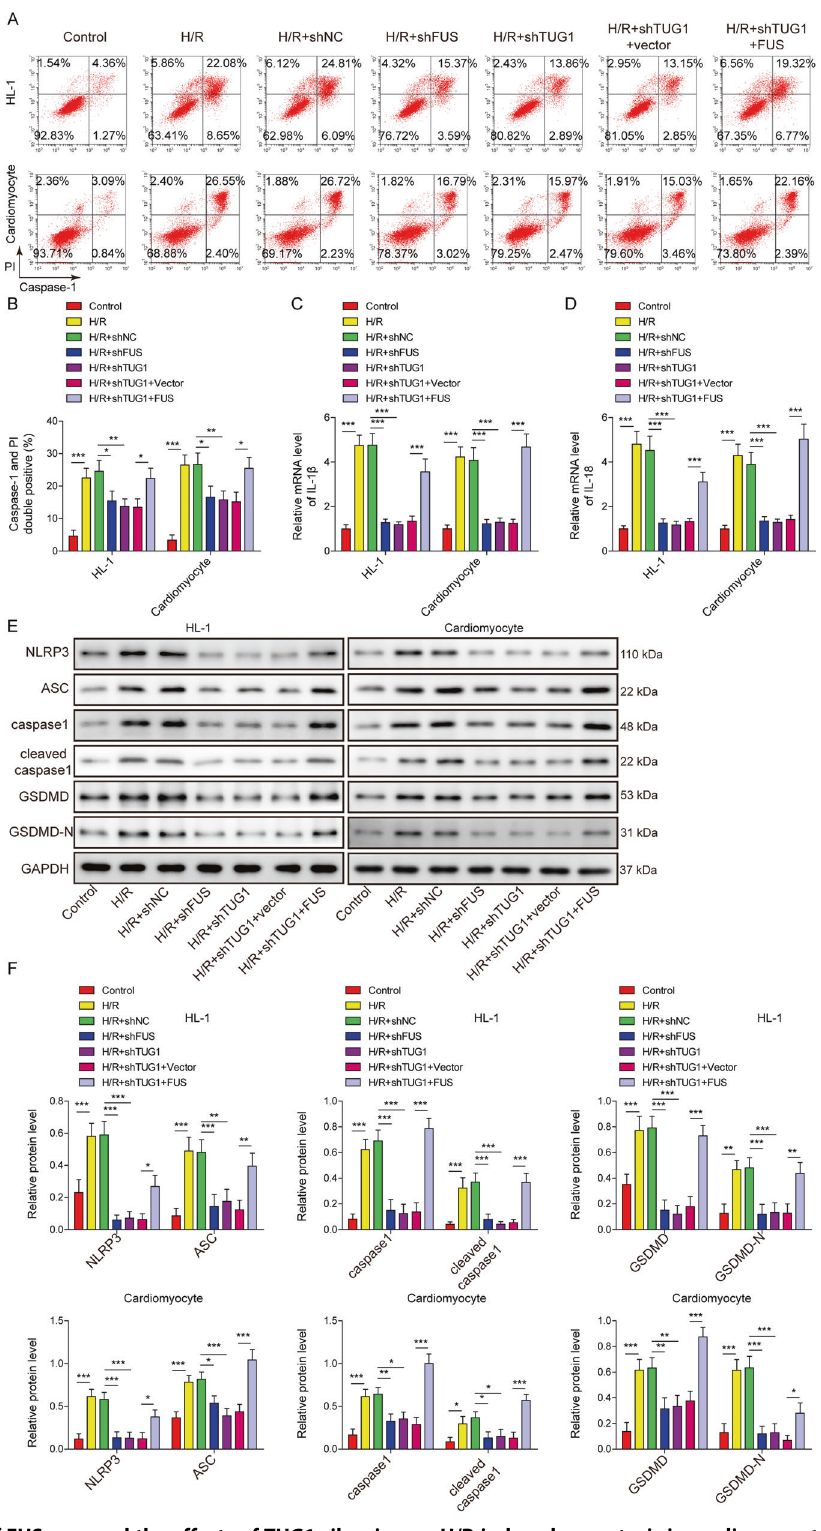
Fig. 5 Overexpression of FUS reversed the effects of TUG1 silencing on H/R-induced pyroptosis in cardiomyocytes. A , B Caspase-1 activity was measured using fl ow cytometry. C IL-1 β and D IL-18 expression was measured using qRT-PCR. E , F The expression of NLRP3, ASC, and other downstream pyroptosis-related factors was measured using western blotting. * P < 0.05, ** P < 0.01 and *** P < 0.001.